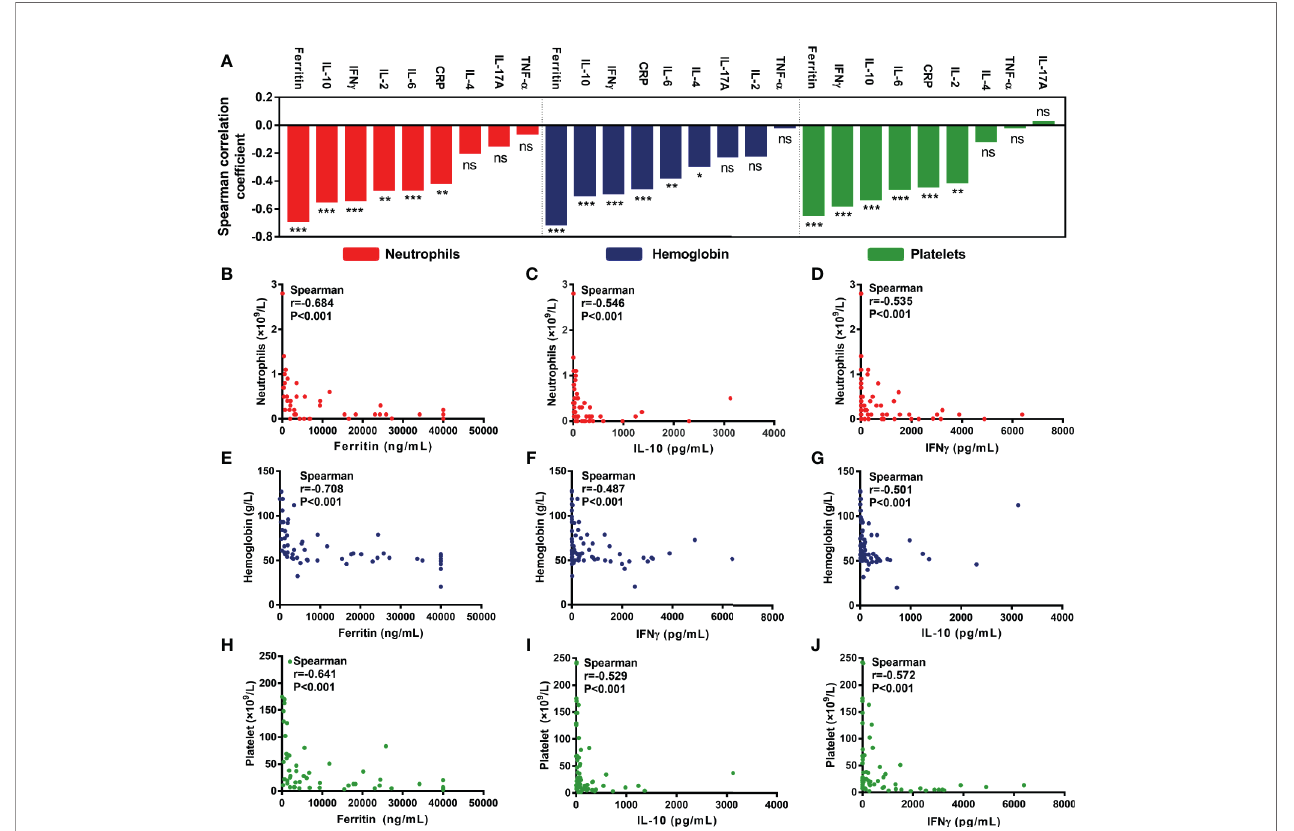
FIGURE 3 | Hematological parameters are correlated with cytokines/serum biochemical markers associated with CRS. (A) An overview of the correlation between minimum hematological parameters after CAR-T cell infusion and peak cytokines or serum biochemical markers associated with CRS. (B – J) Max lg ferritin, IL-10, and IFN g were most signi fi cantly associated with hematological parameters, including neutrophil count (B – D) , hemoglobin concentration (E – G) , and platelet count (H – J) . P values and r values were determined by Spearman correlation analysis. ***P < 0.001, **P < 0.01, *P < 0.05, ns, no signi fi